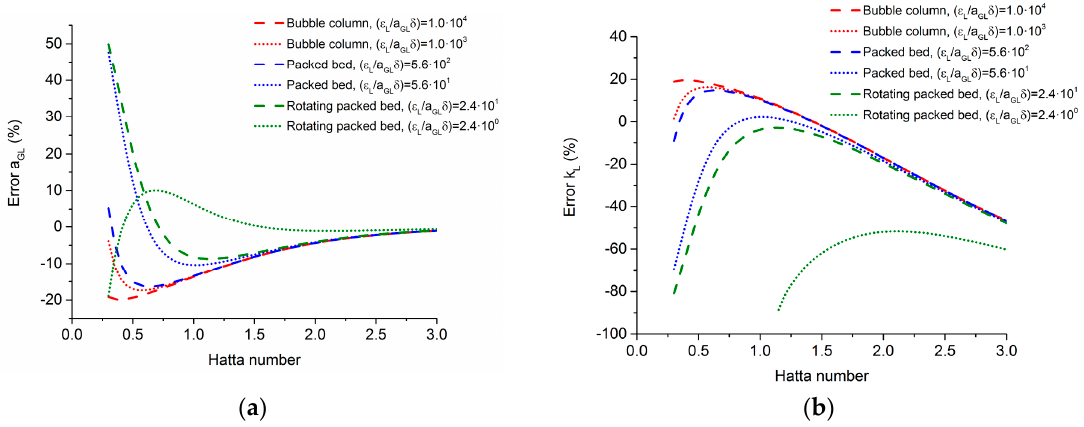
Figure 5. Percentage error in estimation of ( a ) interfacial area ( a GL ) and ( b ) mass-transfer coefficient ( k L ) using the Danckwerts’ plot in the intermediate reaction regime for the different equipment.